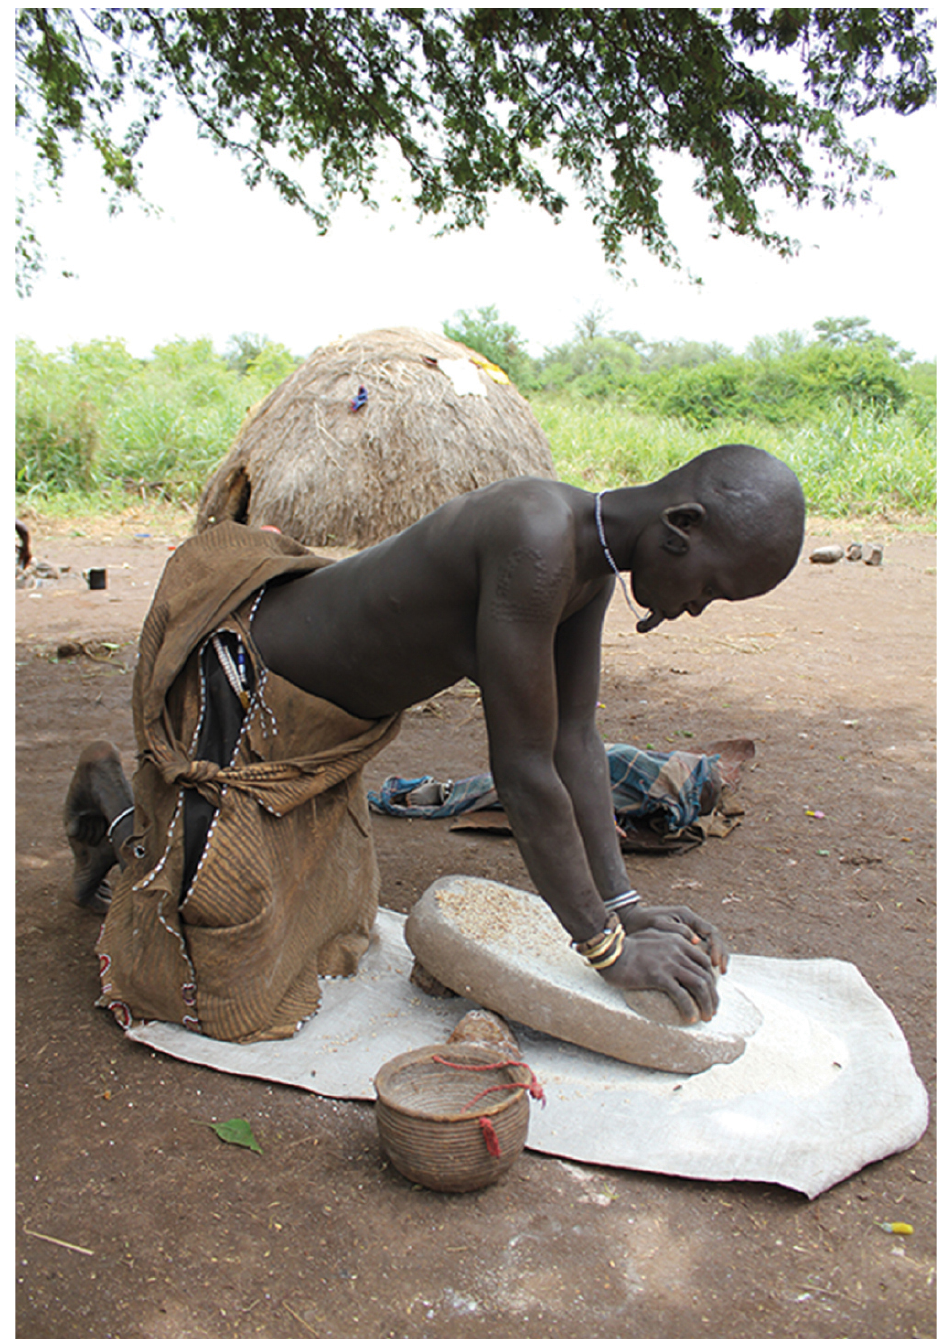
Figure 5. Woman milling wheat on a quern; the handstone is pushed using the palms of the